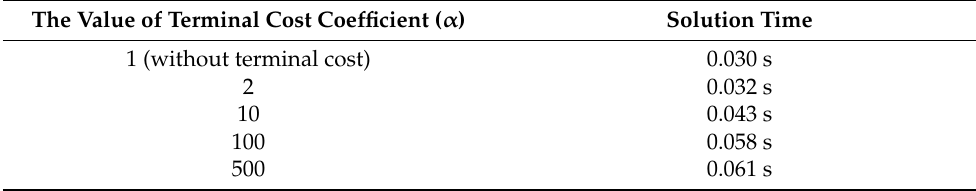
Table 2. The solution time of NMPC. The Value of Terminal Cost Coefficient ( α